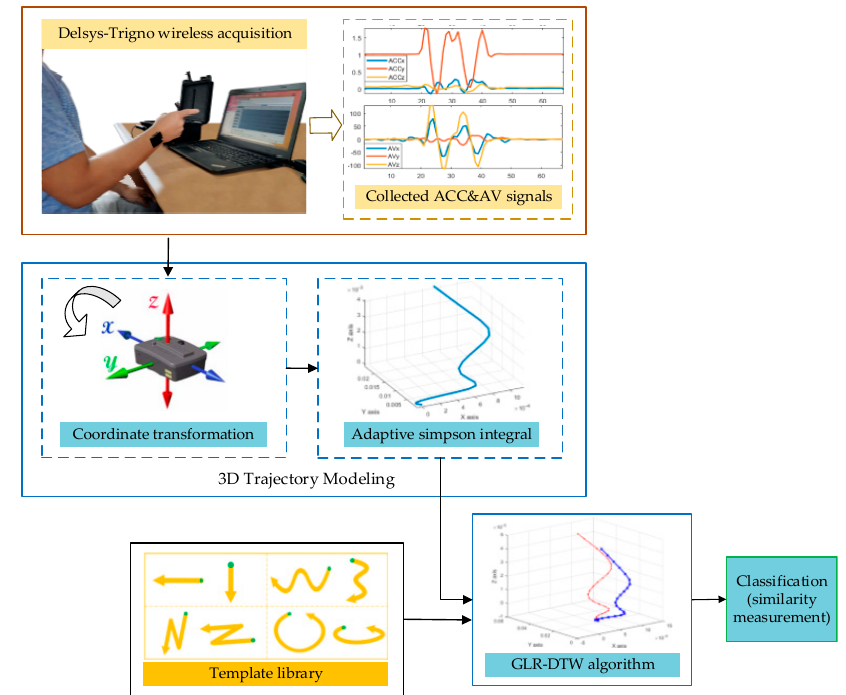
Figure 1. Schematic showing the trajectory recognition steps.